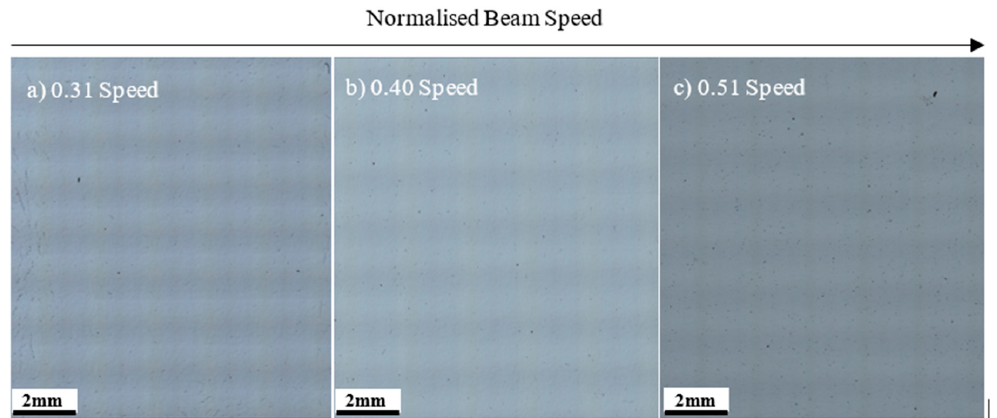
Figure 6. Stitched and blended high-resolution images of material discontinuities in the AB state in relation to normalised beam speed.